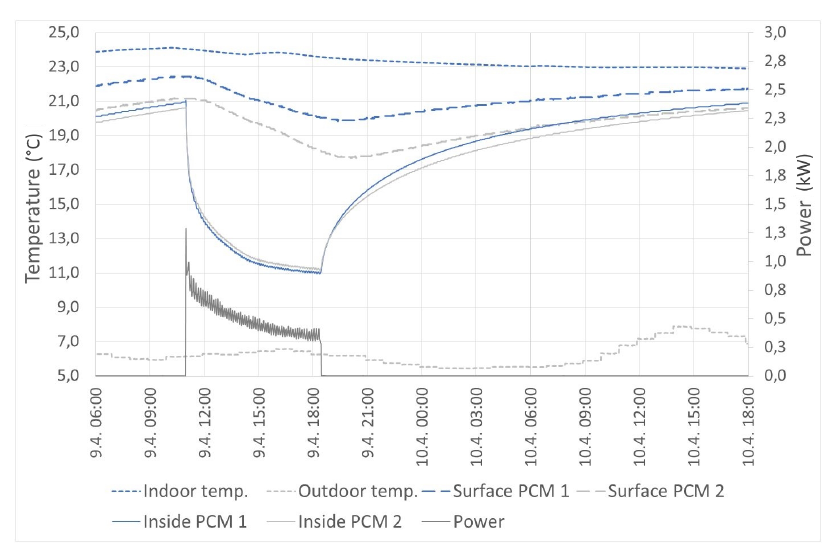
Figure 14. Active mode: